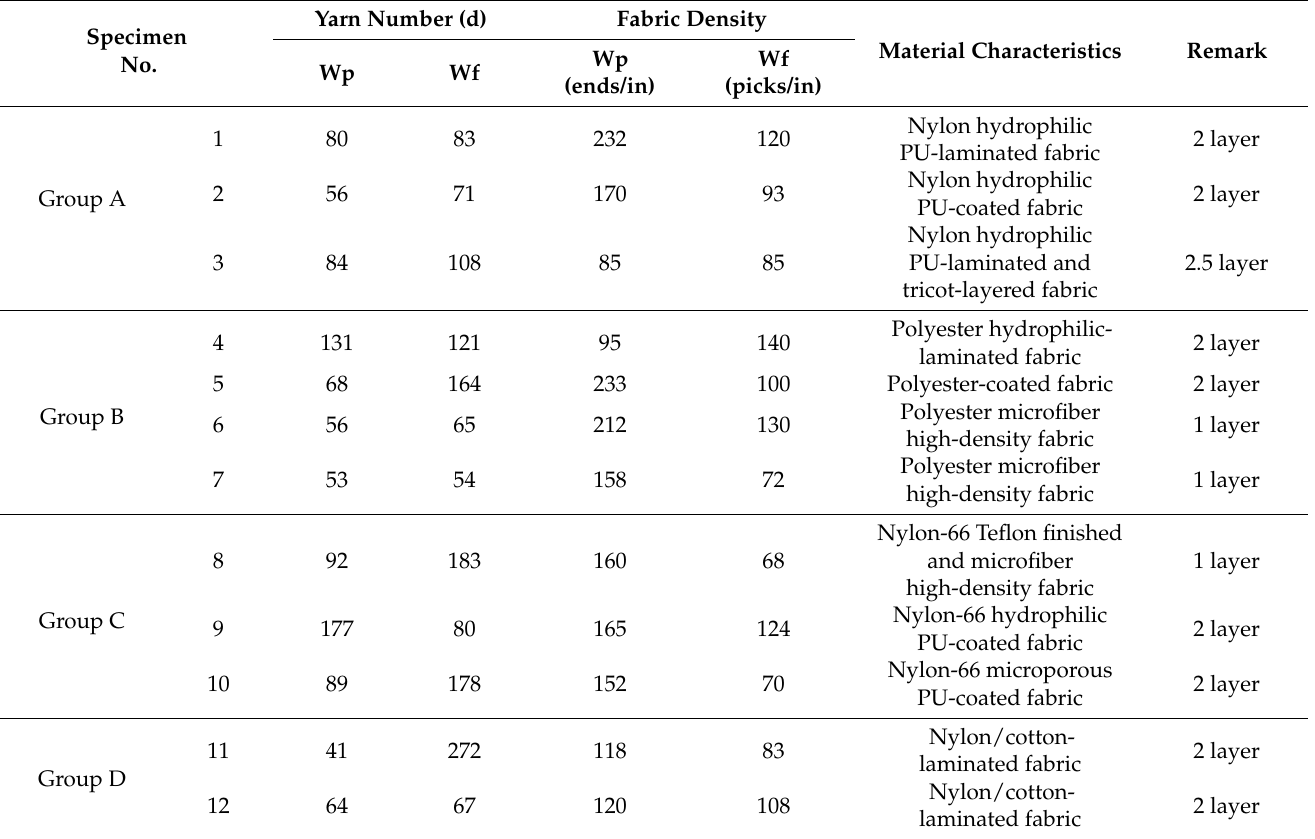
Table 1. Specimens according to materials and surface modification